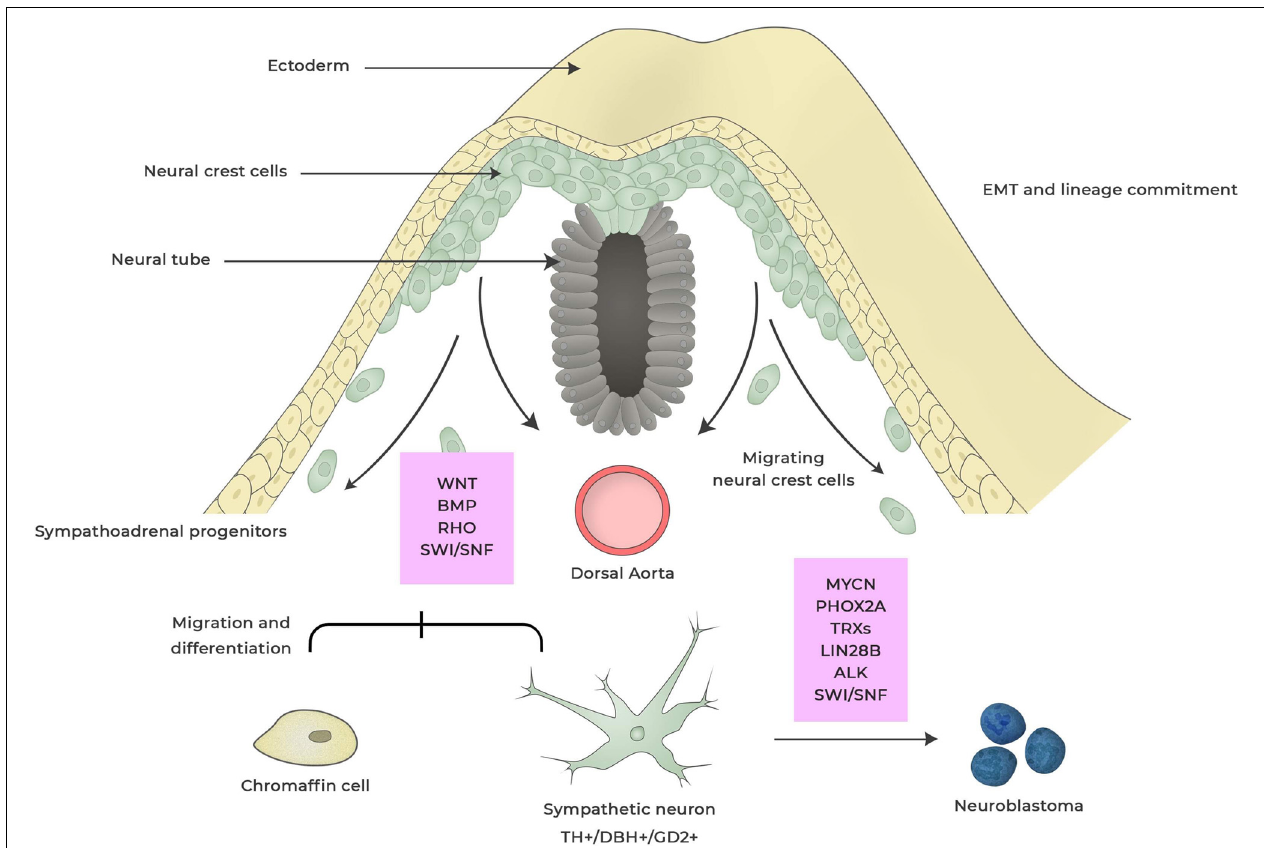
FIGURE 1 | Neuroblastoma development from neural crest. During embryogenesis cells within the neural crest undergo epithelial-to-mesenchymal transition (EMT) enabling cells to delaminate, migrate and differentiate into a wide range of cell types that contributes to anatomical structures within the organism. This process is regulated by a complex set of external signaling, activation of transcriptional programs and epigenetic events. Dysregulation of factors involved in this process can induce changes in cell specification and deregulated-migration and -cell differentiation giving rise to hyperneoplastic lesions that eventually can result in neuroblastoma. These events can occur during different stages of neural crest maturation and factors that are thought to be important for neuroblastoma development are boxed in red. Dysregulated expression of MYCN is the most powerful oncogenic driver for neuroblastoma and induces proliferation and inhibits apoptosis of sympathoadrenal lineage cells whereas LIN28B control MYCN expression via regulating Let-7 miRNA. Anaplastic lymphoma kinase (ALK) and paired-like homeobox 2B (PHOX2B) are germline mutations found in neuroblastoma. Rho signaling is crucial for the migration of neural crest cells by controlling contact inhibition of locomotion between neural crest cells. SWI/SNF complexes are tumor suppressors that for coordinate diverse chromatin alterations which influences the transcriptional output, DNA replication and